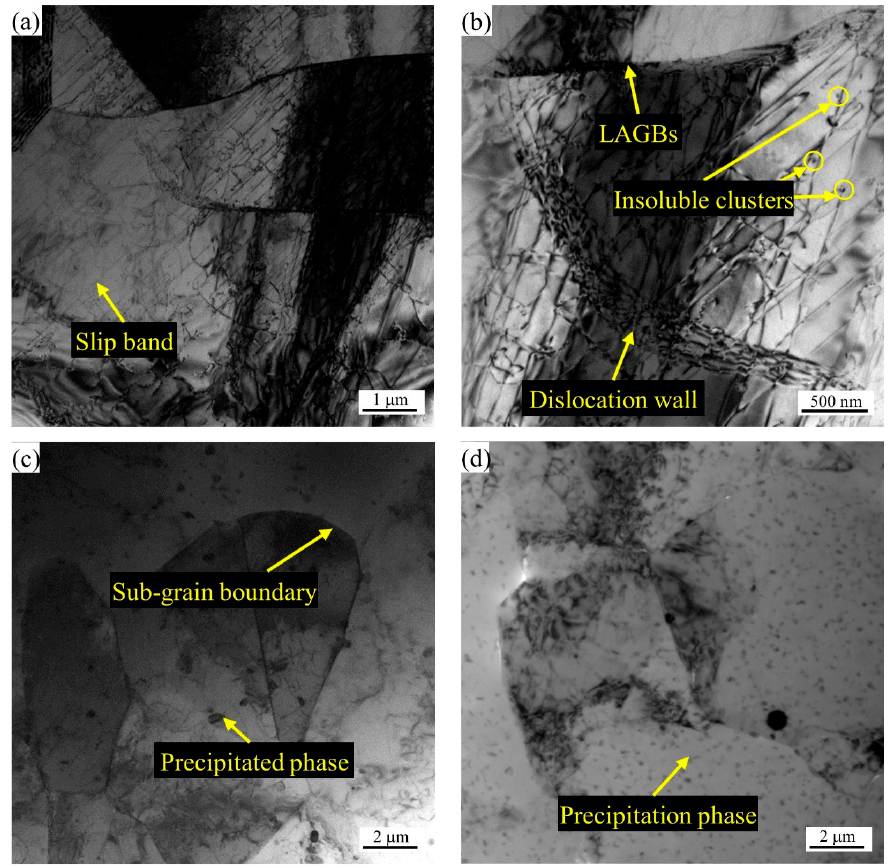
Figure 12. TEM bright fi eld images of the 2A14 alloy after annealing to ( a , b ) 505 °C, ( c ) 555 °C, and ( d ) 580 °C.